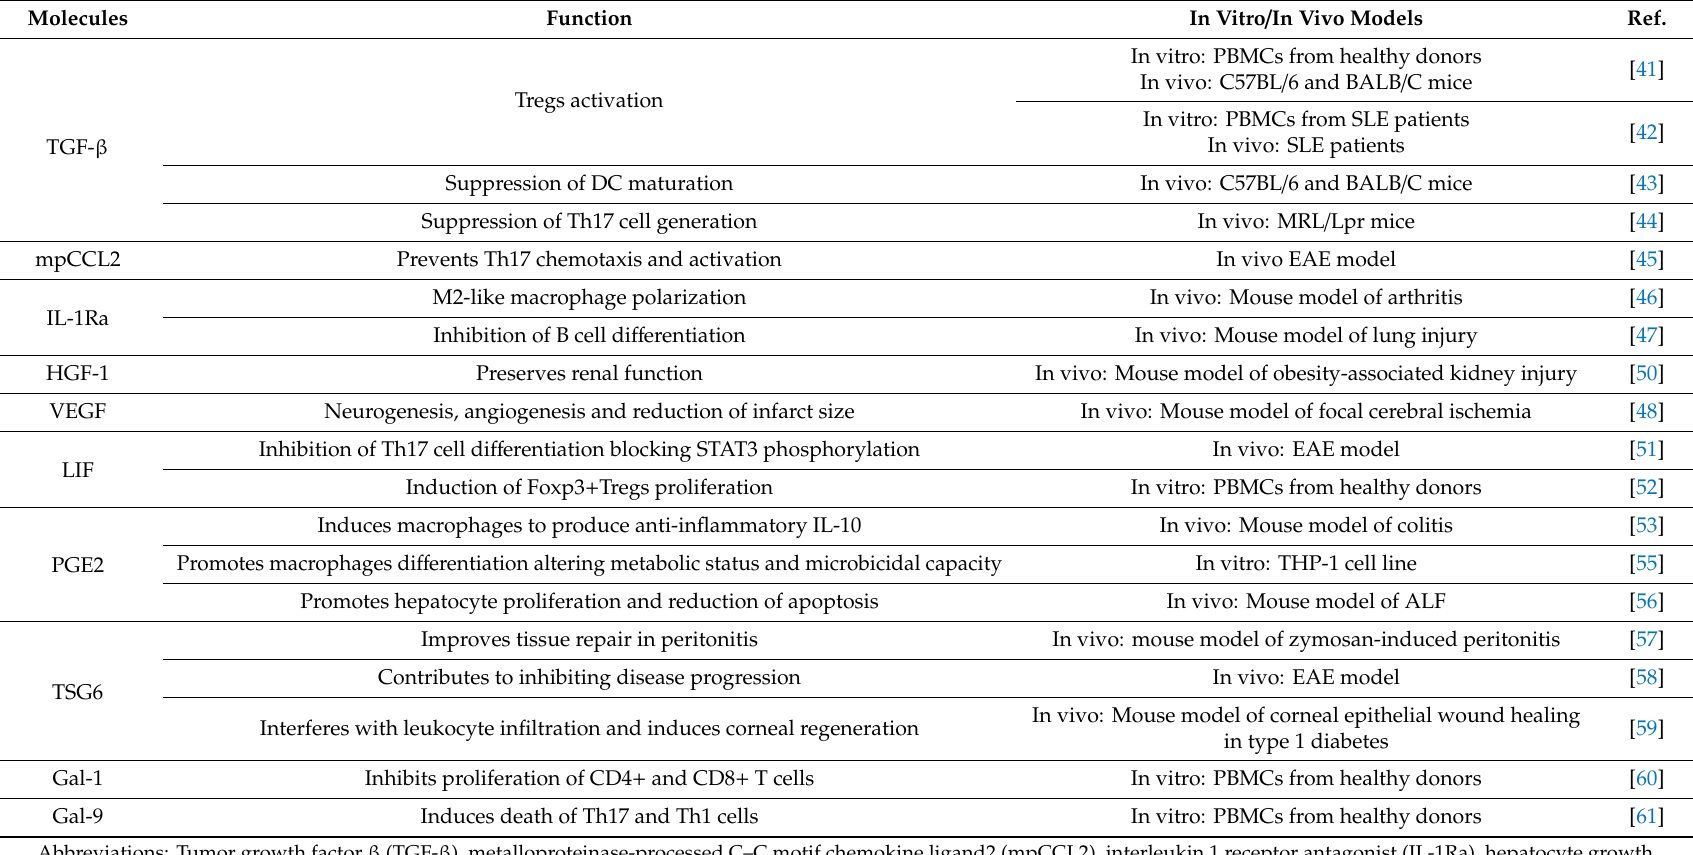
Table 1. Molecules secreted by mesenchymal stem cells (MSCs) and their